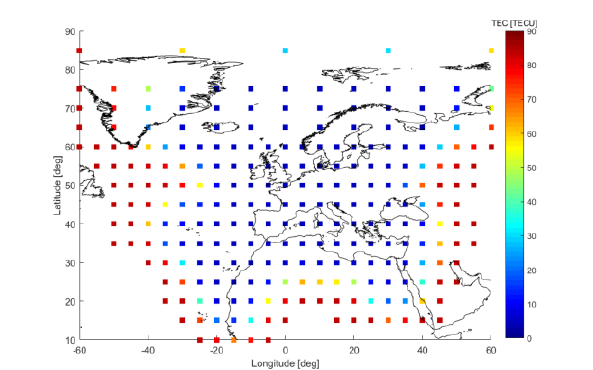
Figure 6. EGNOS model’s annual average RMS values